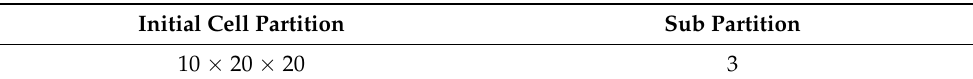
Table 2. Configuration of